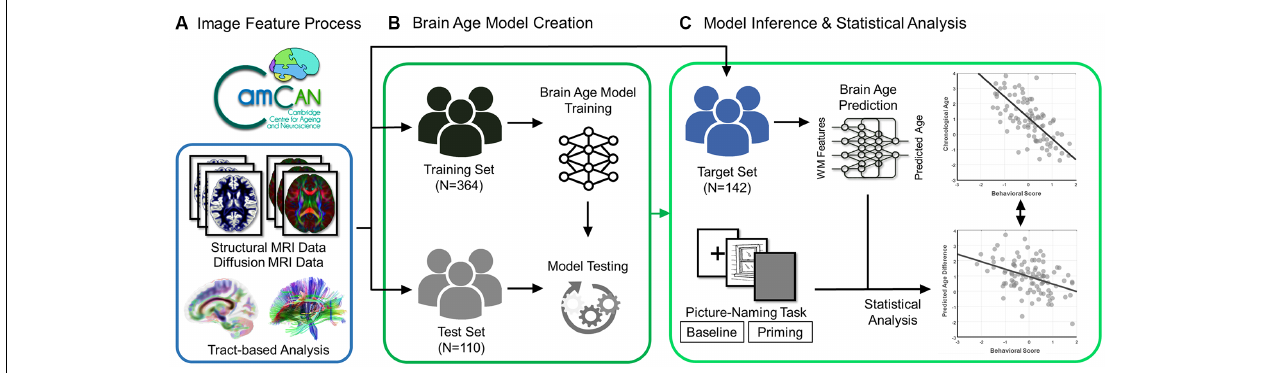
FIGURE 1 | Flowchart of experiment design. The brain scans (structural and diffusion MRI data) and behavioral data (scores of the picture-naming task in baseline and priming conditions) were acquired from the participants in the Cam-CAN Repository. (A) The diffusion MRI data went through the tract-based analysis. (B) The processed data were used to create and test the brain age prediction model in the training and test sets, respectively. (C) Eventually, the established brain age model was applied to the target set to predict the value of the predicted age difference (PAD). The statistical analysis was further conducted to estimate the association of behavioral scores with chronological age and predicted age difference in the target set.